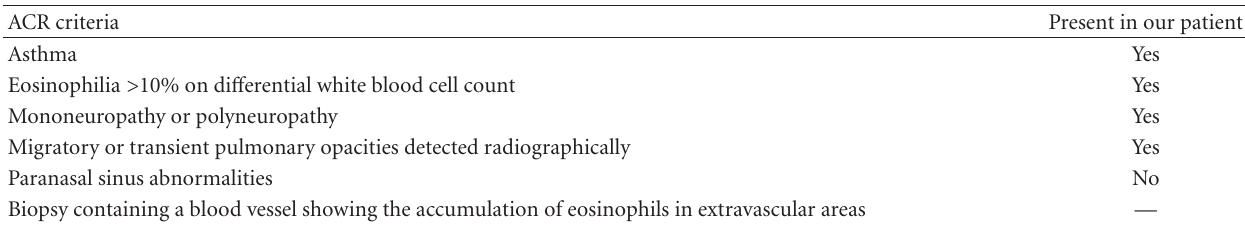
Table 1: Criteria for the classification of Churg-Strauss syndrome (CSS). The presence of four or more of these criteria yields a sensitivity of 85% and a specificity of 99.7% for CSS according to the American College of Rheumatology